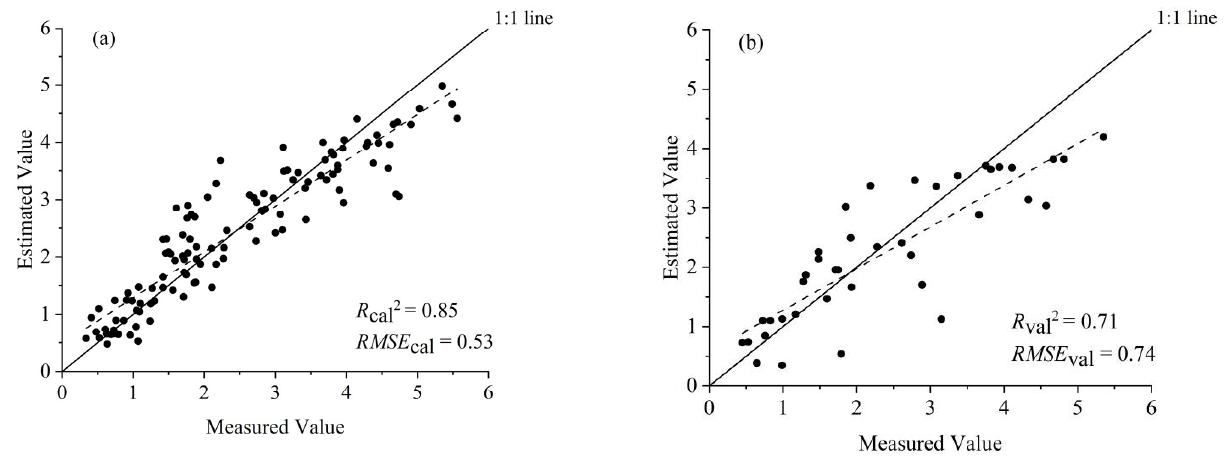
Figure 9. Results for the GPR model. ( a ) Calibration; ( b ) validation.